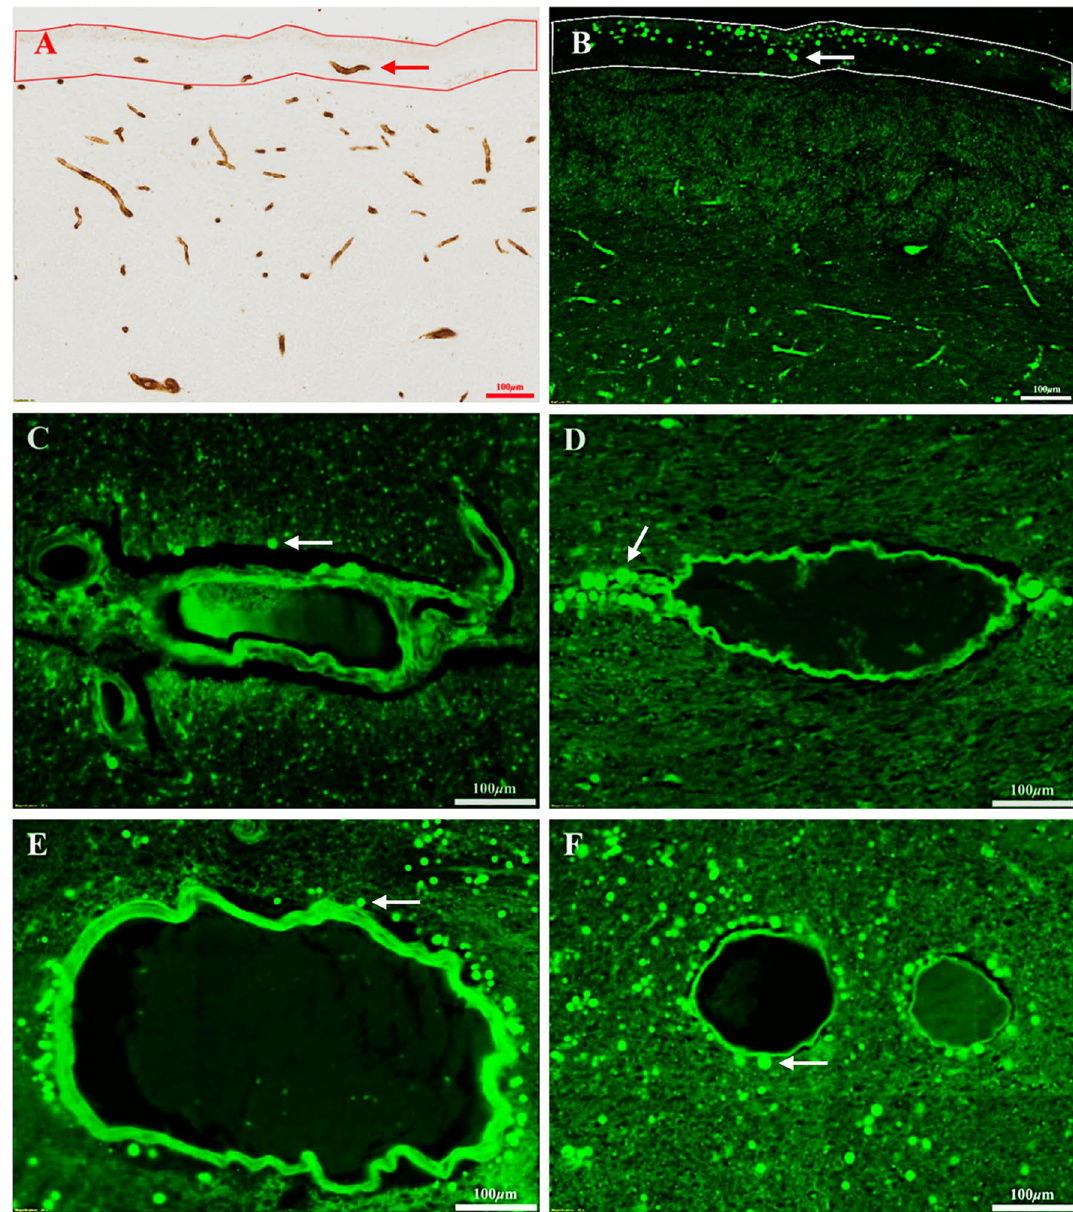
Figure 4. Adjacent brain sections showing the inverse relationship between microvasculature ( A ; immunolabeled with Collagen IV and GluT-1) and CoA ( B ) in the alveus pial surface region. There are very few microvessels within 100 µm of the pial border (avascular zone, red enclosed zone in panel A ), whereas CoA reach their peak abundance in this zone (white enclosed zone in panel B ). An example of an individual microvessel is indicated by the red arrow in A, and an individual CoA is indicated by the white arrow in ( B ). The deposition of CoA in relation to arterioles ( C , E ) and venules ( D , F ) in the deeper neuropil ( C , D ) and subpial regions ( E , F ). Examples of individual CoA are indicated by white